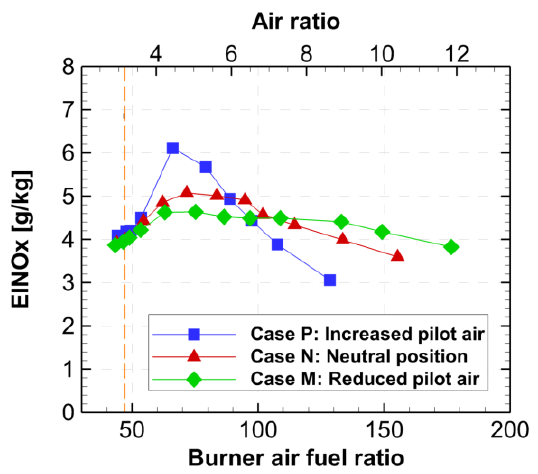
Figure 13. NO x emission index under idling conditions. (Copyright by ASME — "Effects of Fluidic Control of Air-Flow Distribution on Staged Lean Jet Engine Burner," by Yoshida, Schneider, Hassa, Paper No: GT2016-57453).